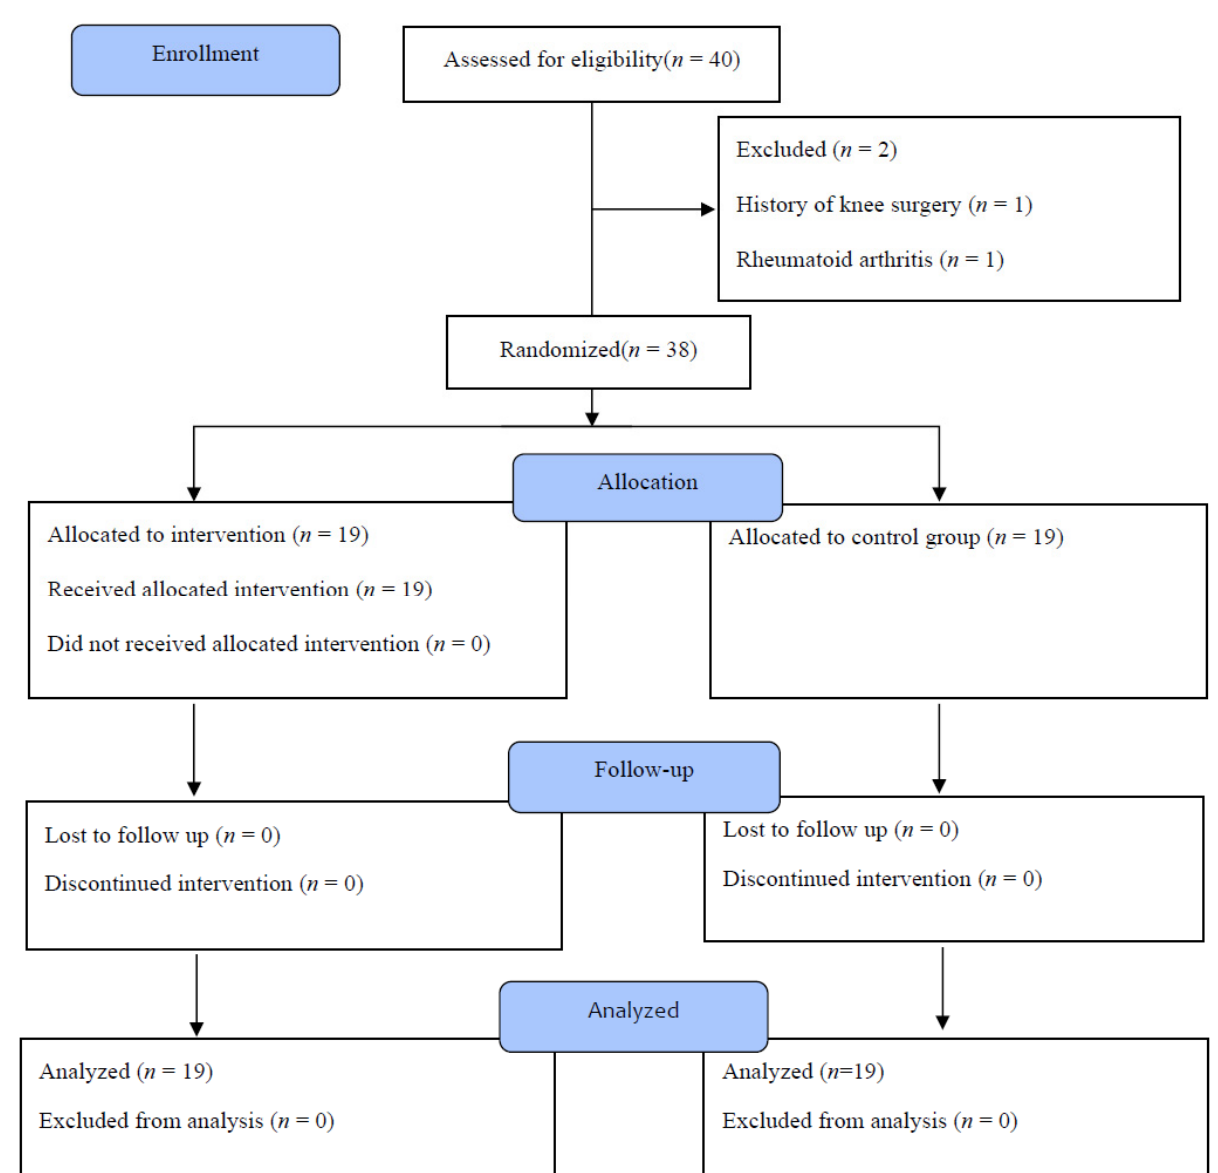
Figure 1. Consort flowchart diagram of the study participants.